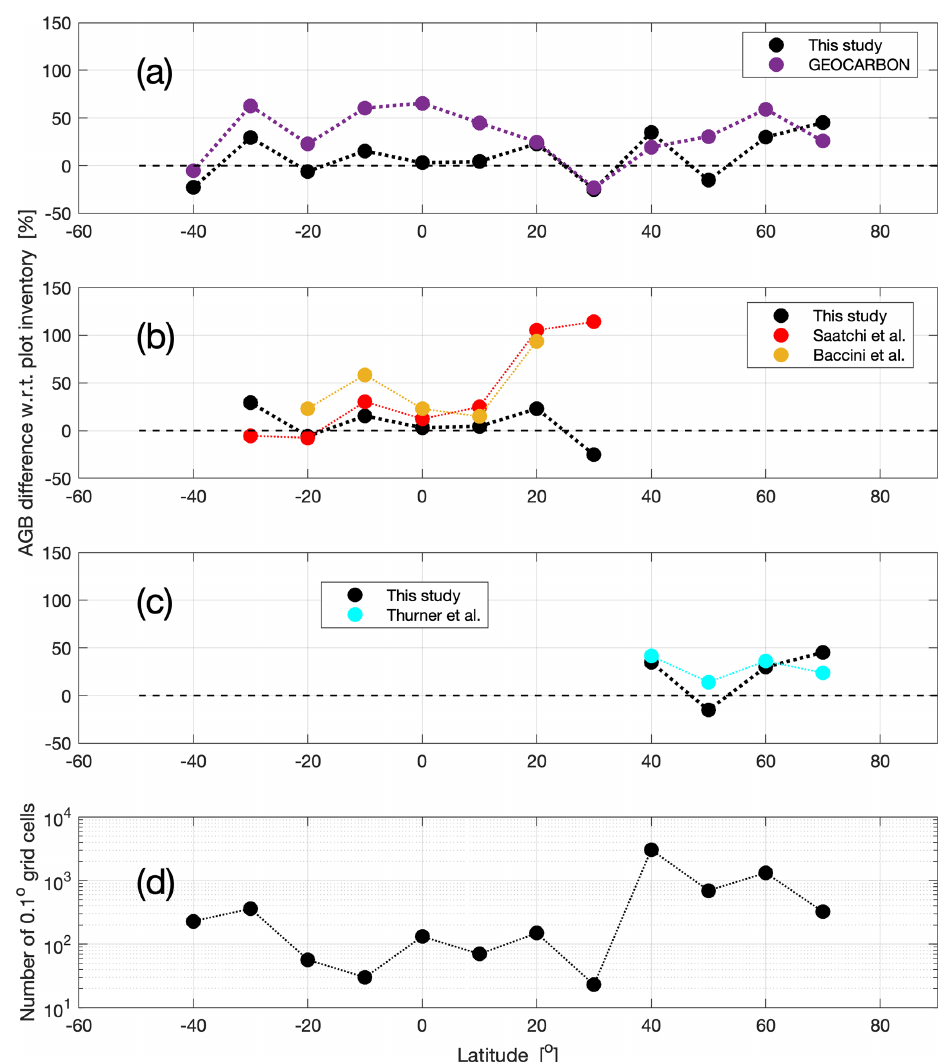
Figure 11. Relative difference in AGB from maps and plot inventory data averaged over the 0.1 ◦ grid cell validation cells (a–c) . The number of grid cells stratified by 10 ◦ wide latitude intervals is illustrated in (d)